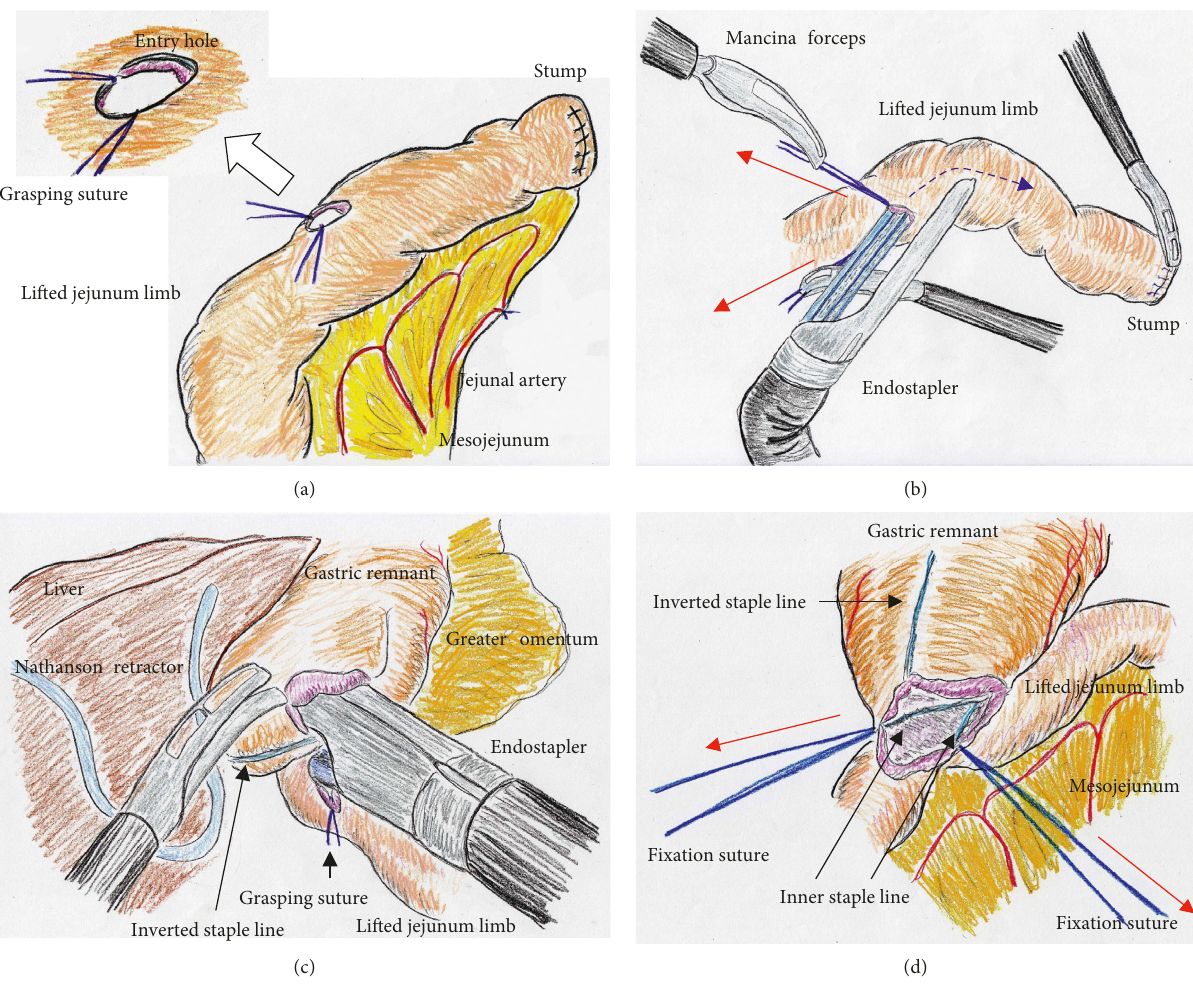
Figure 2: (a) The entry site for the endostapler was extracorporeally made. Two anchor sutures were preplaced. (b) Under countertraction by the two anchor sutures (red arrows), the endostapler was guided into the lifted jejunal limb (dotted blue line). (c) The endostapler was used side-to-side to attach the lifted jejunal limb to the gastric remnant in an isoperistaltic direction. (d) Two full-thickness anchor sutures (red arrows) were